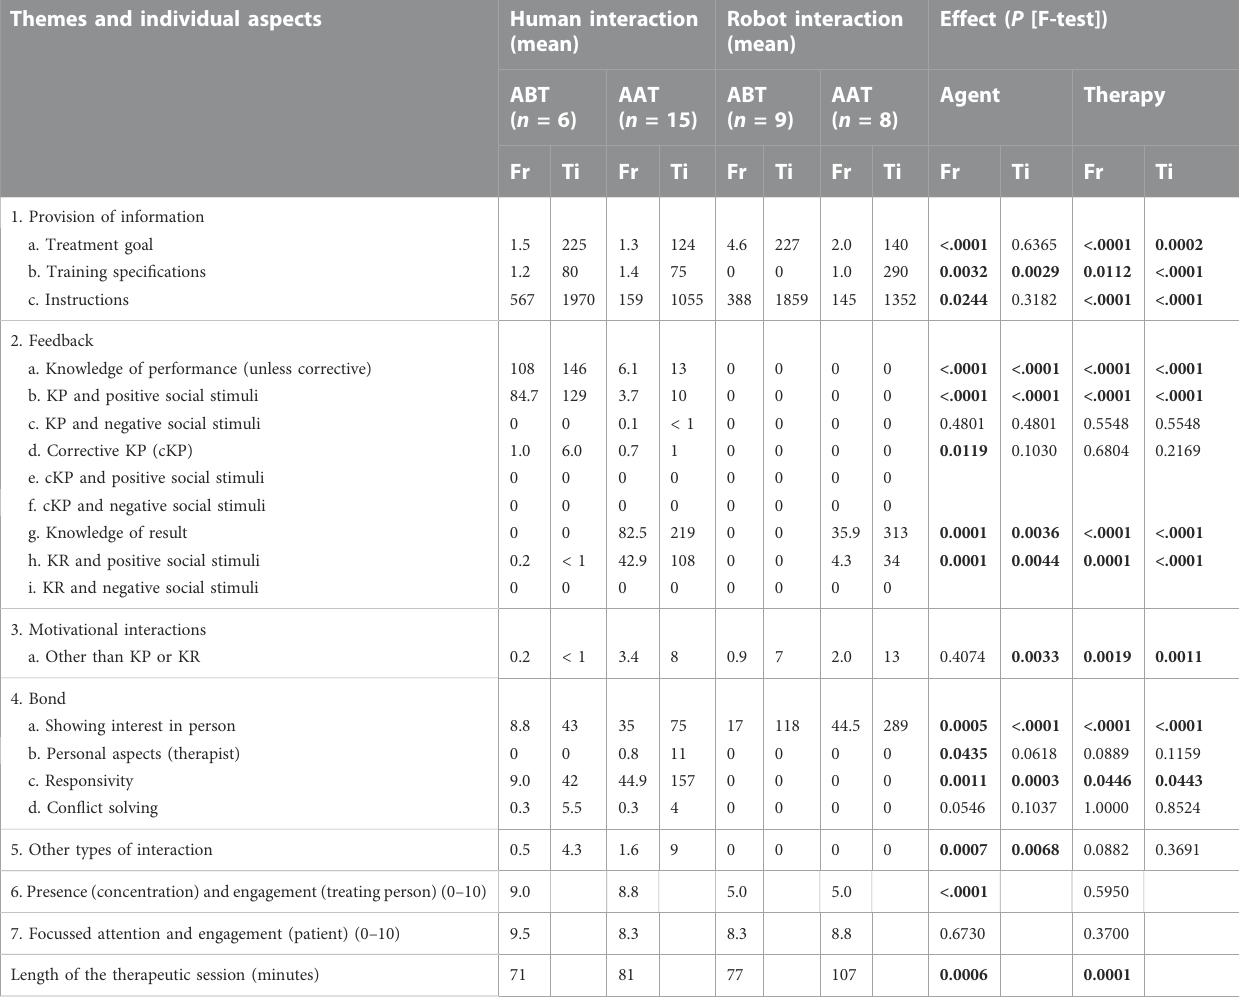
TABLE 4 Ther-I-Act observations: Variation of the therapeutic interaction by agent and type of therapy (day 1 of therapy) ( n = 38). Themes and individual